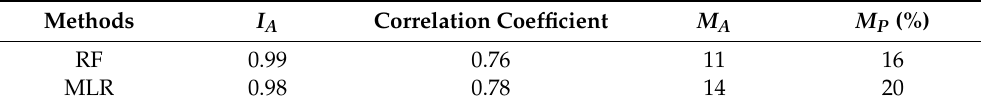
Table 6. I A , correlation coefficient, M A , and M P of two methods for predicting PM 10 concentration during clean period.